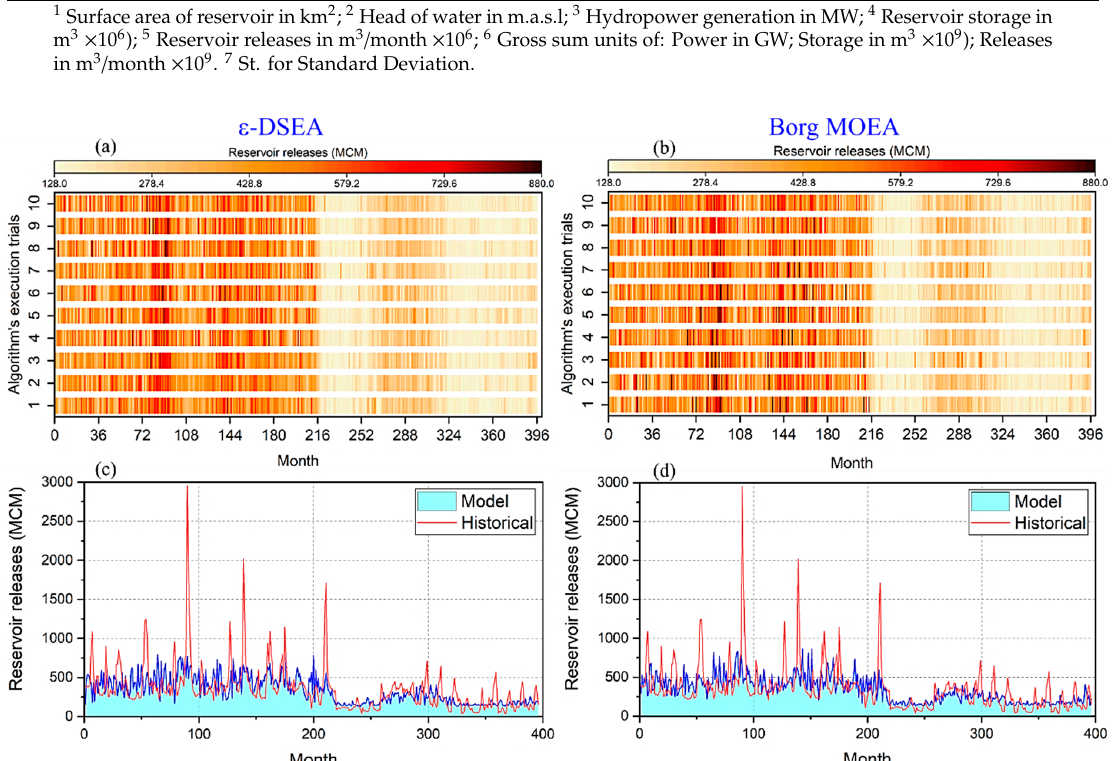
Figure 8. Comparative graphs between achieved releases of both algorithms based on maximizing hydropower generation objective. ( a ) and ( b ) show detail results for 10 runs, while ( c ) and ( d ) illustrate historical and model releases.